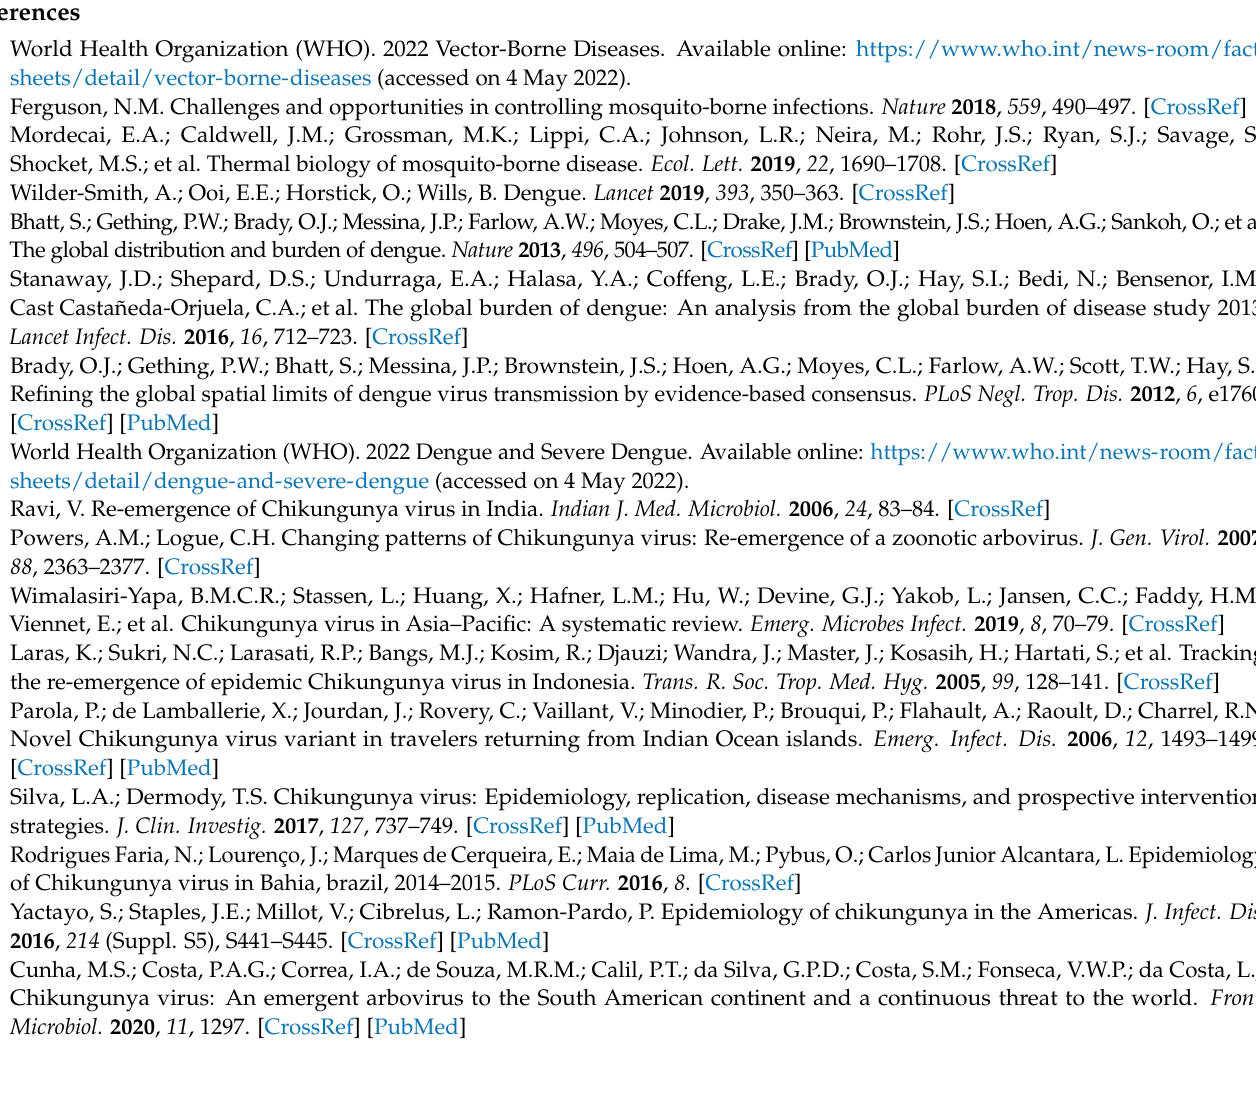
plot and LFK index; Table S1: Searching string details; Table S2: Characteristics of studies included in the systematic review; Table S3: Risk of Bias (RoB) assessment; Table S4: Knockdown resistance ( kdr ) mutations that have been detected in different mosquito populations in Asia Region; Tables